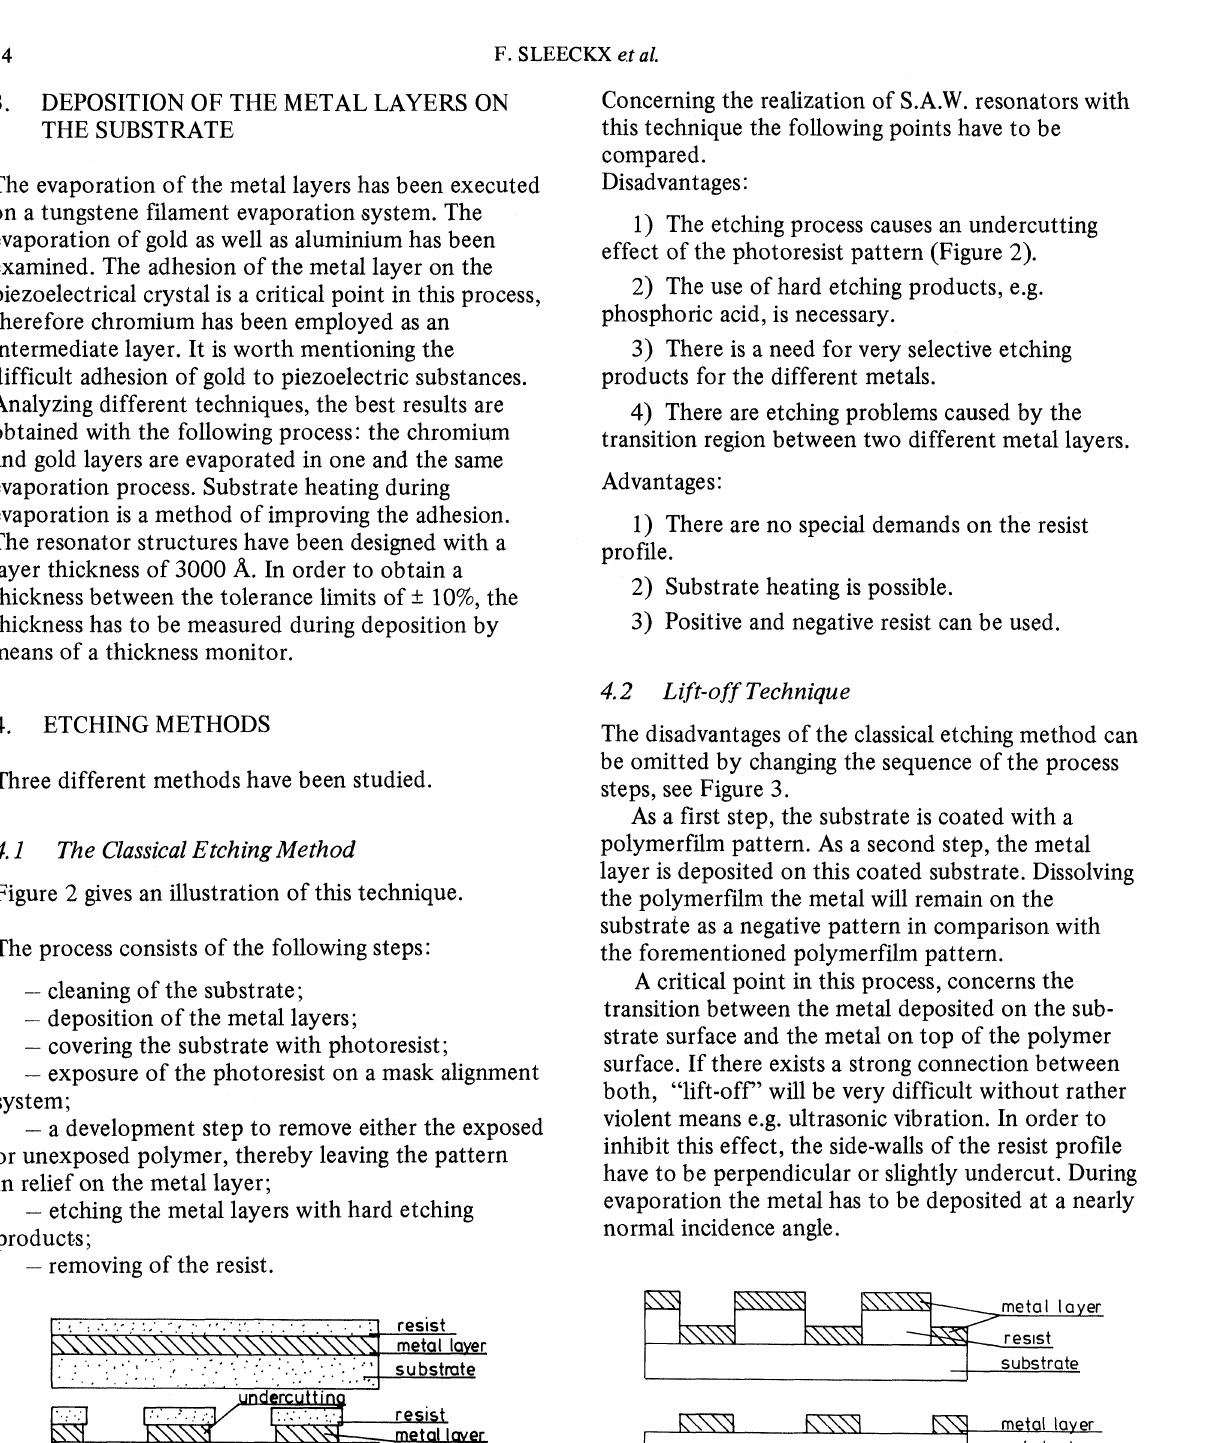
Lift-off technique after deposition of the metal layers after removing of the